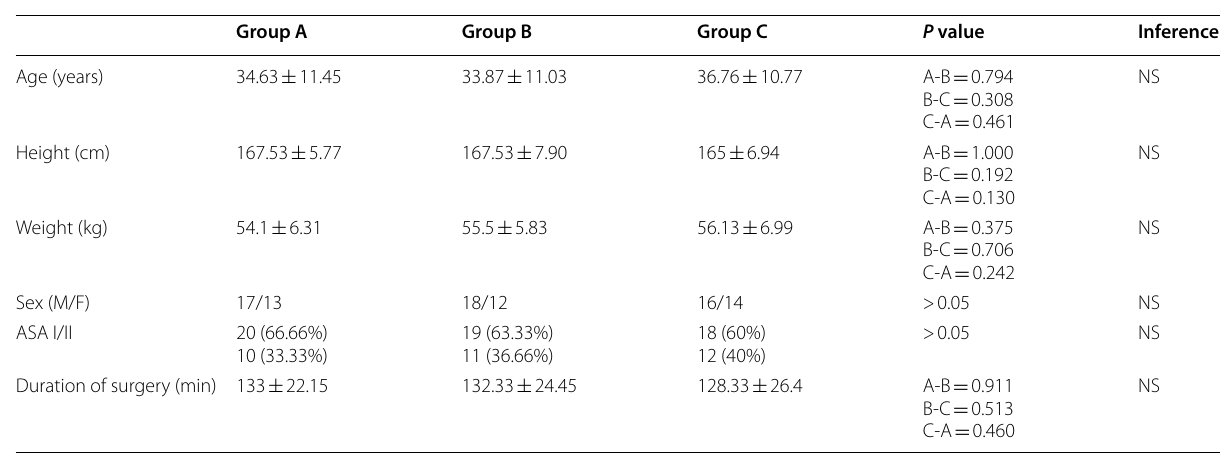
Demographically all groups are comparable. There were no significant differences among them OAA score and vitals monitoring: OAA score and SpO 2 , HR, SBP, DBP, and respiratory rate were monitored periodically in each patient in each group perioperative period. There was no statistically significant difference present among the three groups at any time during the study ( P >